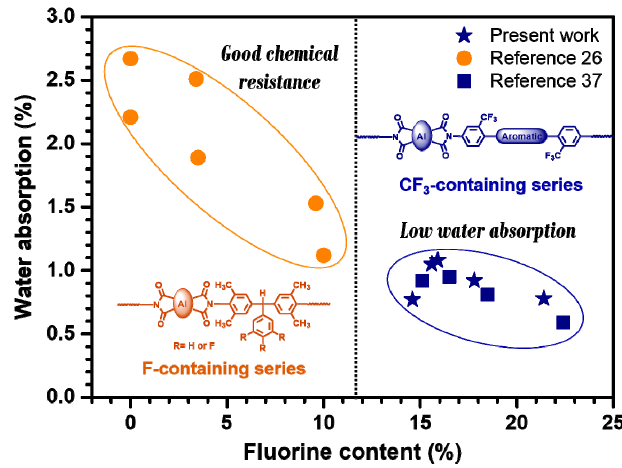
Figure 5. The correlation between fluorine content and water absorption of semi-alicyclic polyimides and comparison with other semi-alicyclic systems reported in the previous work [26,37].